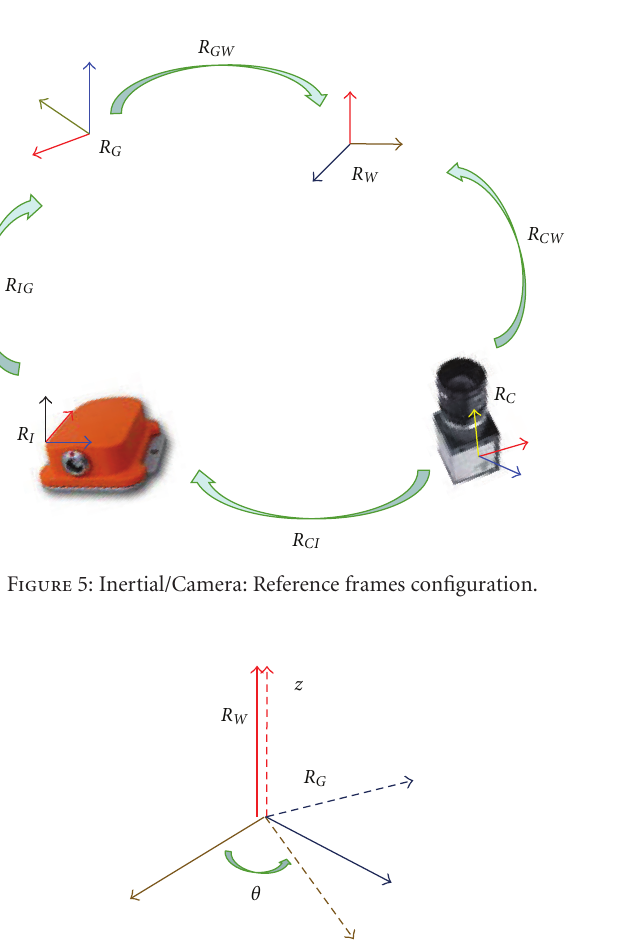
Figure 6: The relationship between the world reference frame R W and the global inertial reference frame R I